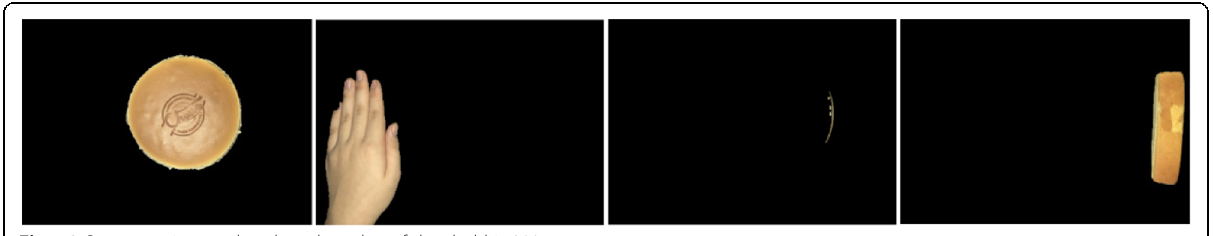
Fig. 13 Segmentation results when the value of threshold is